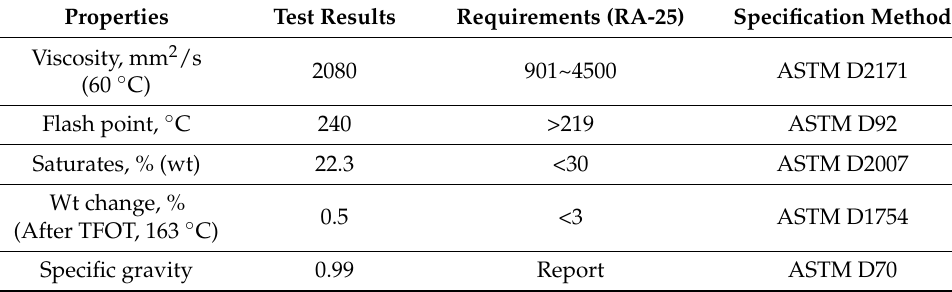
Table 1. Properties of CR used in this